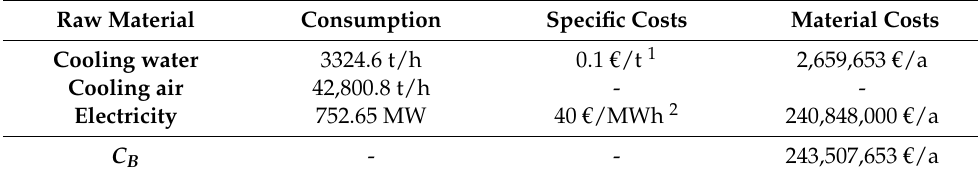
Table 6. Operating costs for the power-to-fuel